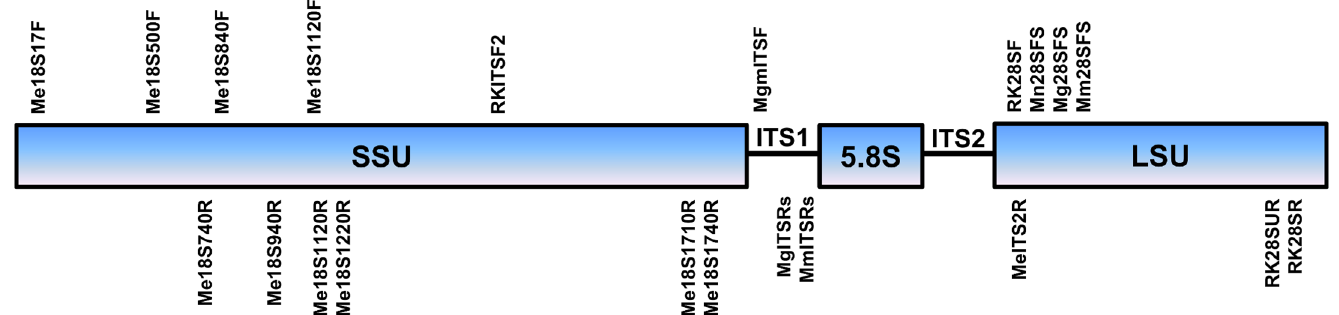
Fig 1. Prime map for PCR amplification and DNA sequencing on ribosomal DNA of Meloidogyne species. Primers on the top are the forward primers and primers on the bottom are the reverse primers.